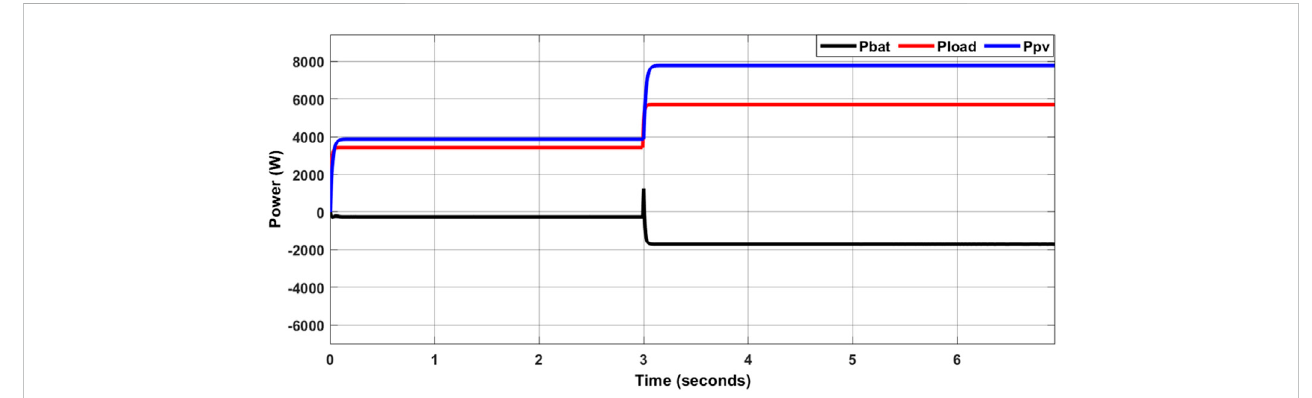
FIGURE 16 Power curves of the PV system, load and battery with changes in both PV and load.